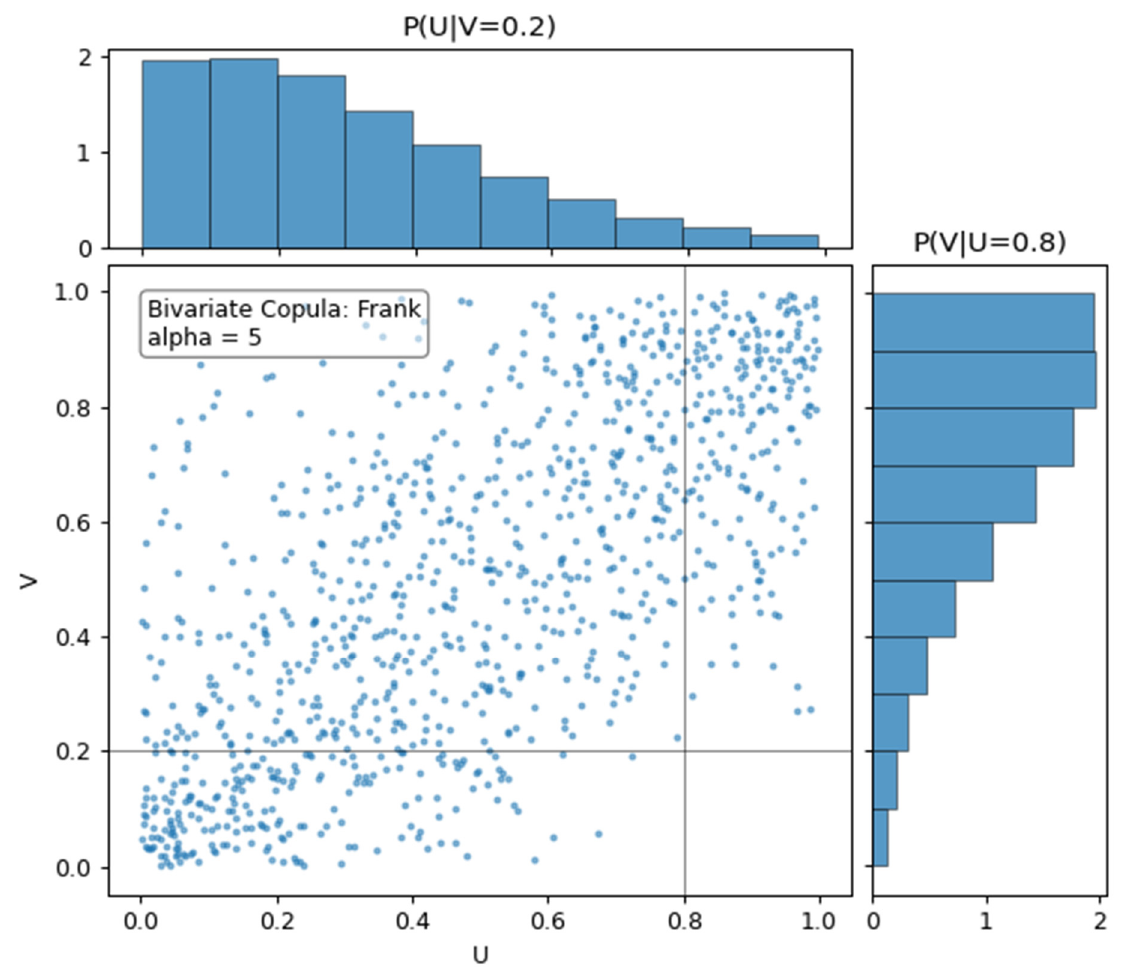
Figure 6. Bivariate Frank copula fitted to the {U: CPI, V:PPI} variable pair and an example of the histograms of the conditional distributions.